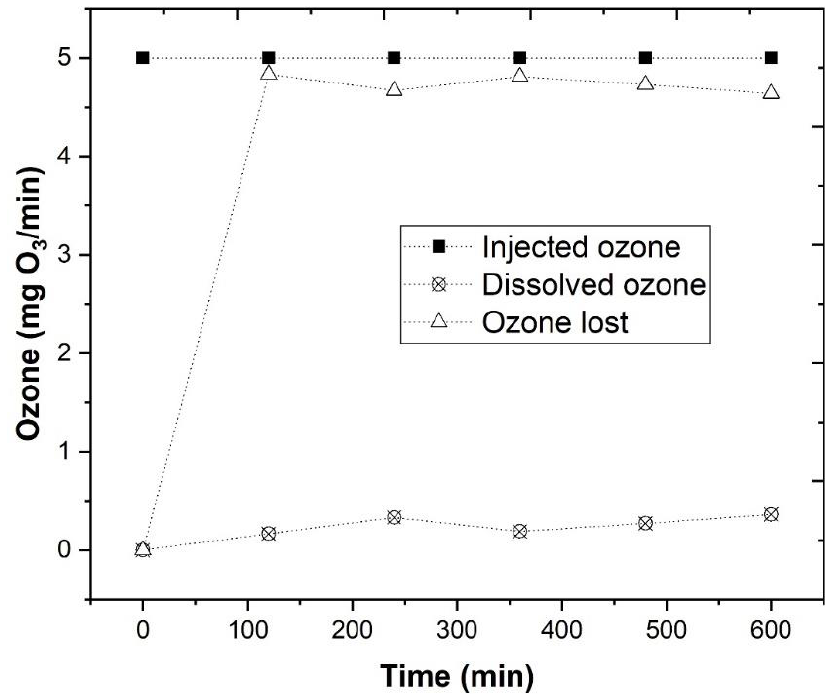
Figure 8. Evaluation of the O 3 concentration dissolved within the WW, by application of the indigo ozone reagent. O 3 /Fe 2+ /UV-C experimental conditions were as follows: pH = 4.0, [Fe 2+ ] = 1.0 mM, ozone flow rate 5 mg/min, air flow 1.0 L/min, agitation 350 rpm, time 600 min, radiation UV-C mercury lamp (254 nm).